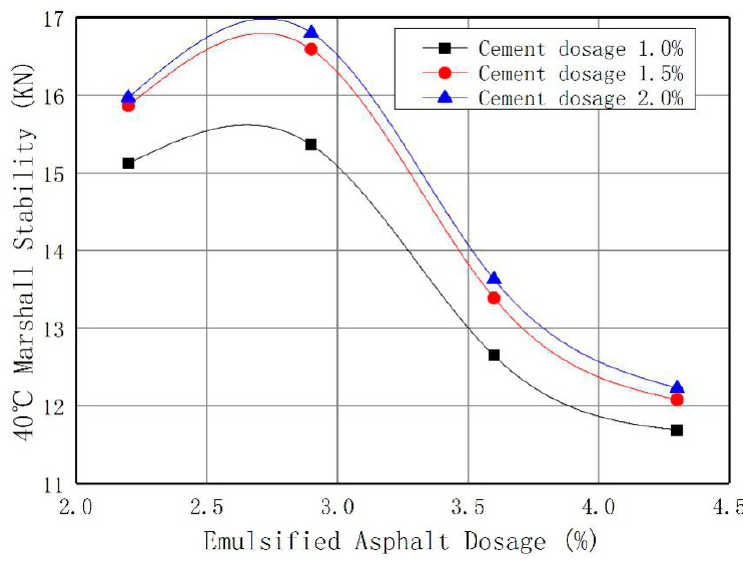
Figure 2. Marshall Stability Trend Chart.